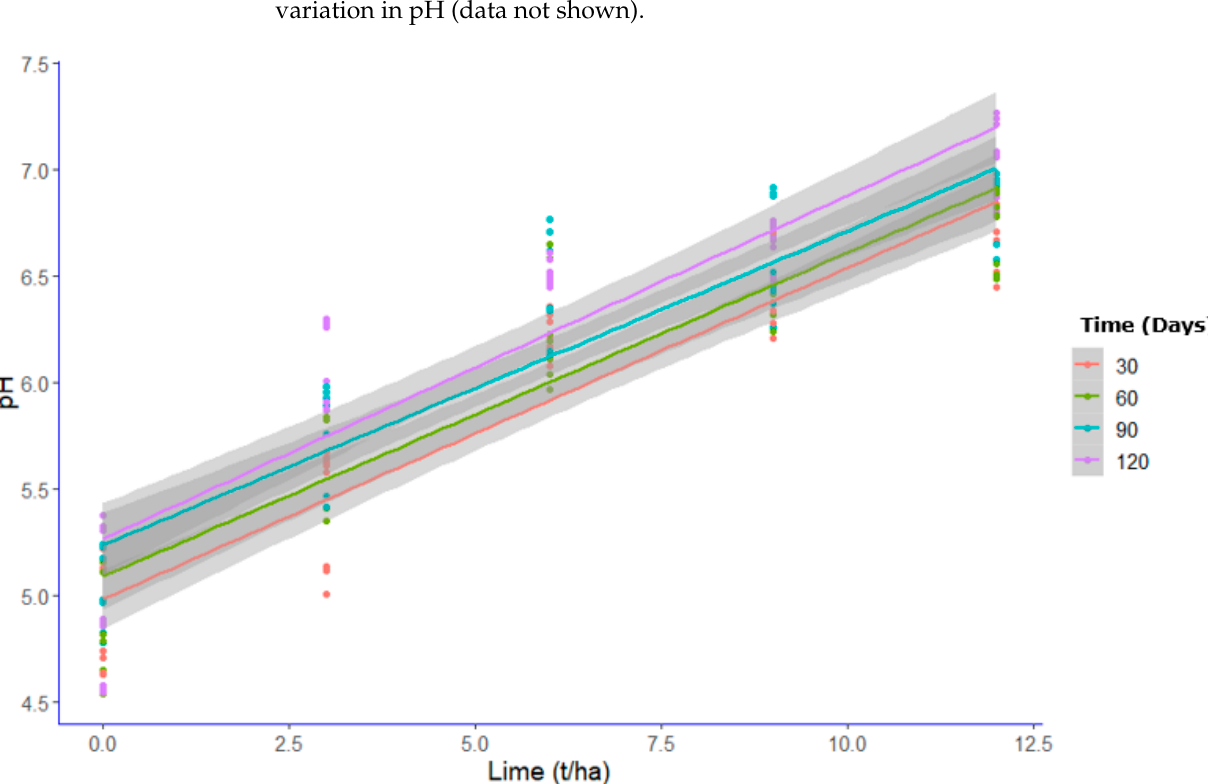
Figure 4. Linear regression curves showing highly significant positive relationships between soil pH and lime application for different dates of measurement (R = 0.93, p < 2.2 × 10 –16 after 30 days, R = 0.91, p < 2.2 × 10 –16 after 60, 90 and 120 days).